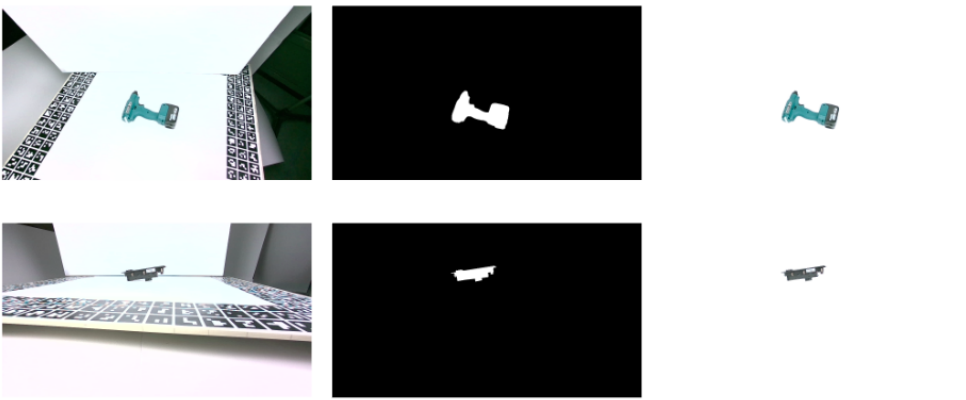
Figure 10. Examples of initially captured ( left column) and final training ( right column) images, masked using the U-Net masks ( middle